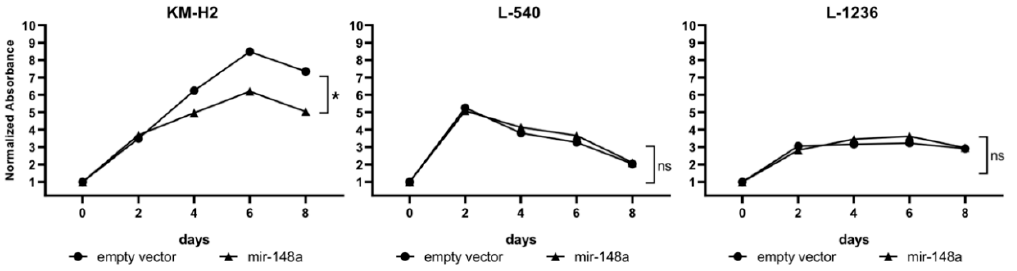
Figure 6. cHL cell lines (KM-H2, L-540, L-1236) viability after mir-148a overexpression (CCK-8 test). Results presented as a mean from three independent experiments, each performed in four replications.